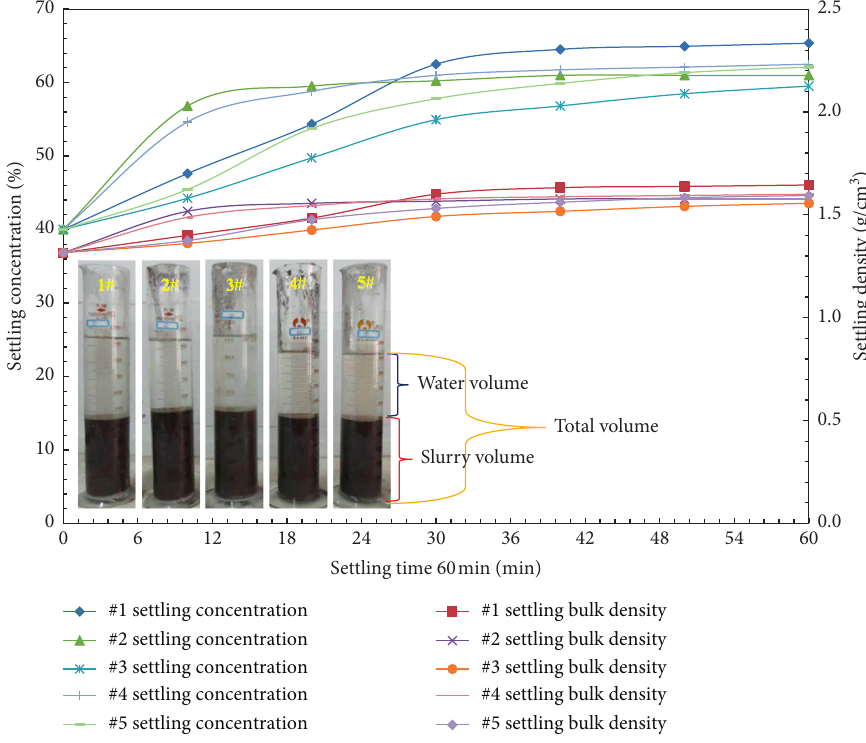
Figure 14: Curves of settling concentration and bulk density